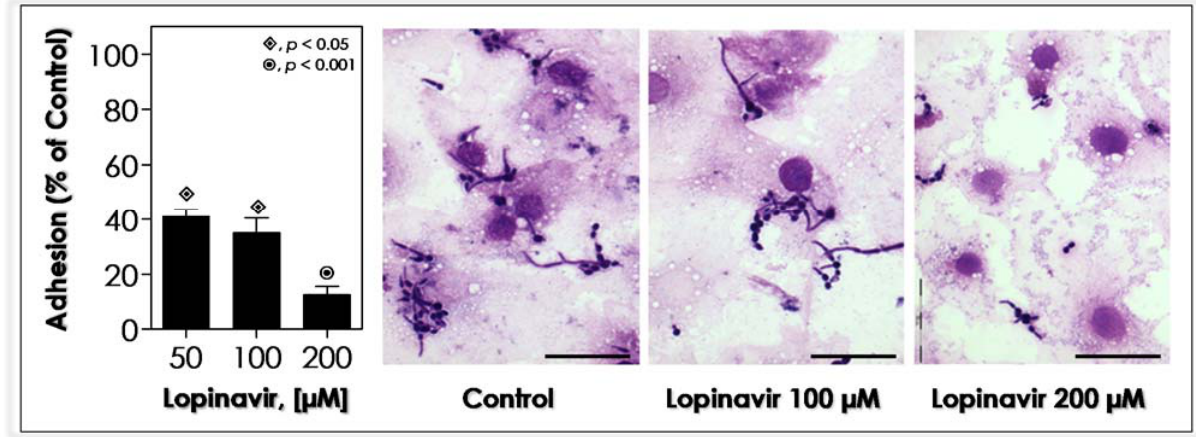
Figure 9. Effect of lopinavir on the interaction process between C. albicans and epithelial cells (HEp-2 lineage). In this set of experiments, untreated and lopinavir-treated yeasts were added to the monolayer in a ratio of 10:1 (fungi:epithelial cell), and then the systems were incubated at 37 °C in 5% CO 2 for 1 h. Systems were washed with PBS, fixed in Bouin’s solution and stained with Giemsa. The percentage of infected epithelial cells was determined by randomly counting at least 200 animal cells in a light microscopy. The values represent the mean ± standard deviation of three independent experiments performed in triplicate. The symbols indicate the experimental systems considered statistically significant from the control (Student’s t -test). Representative images of the interaction process are shown. Bars = 20 µm.